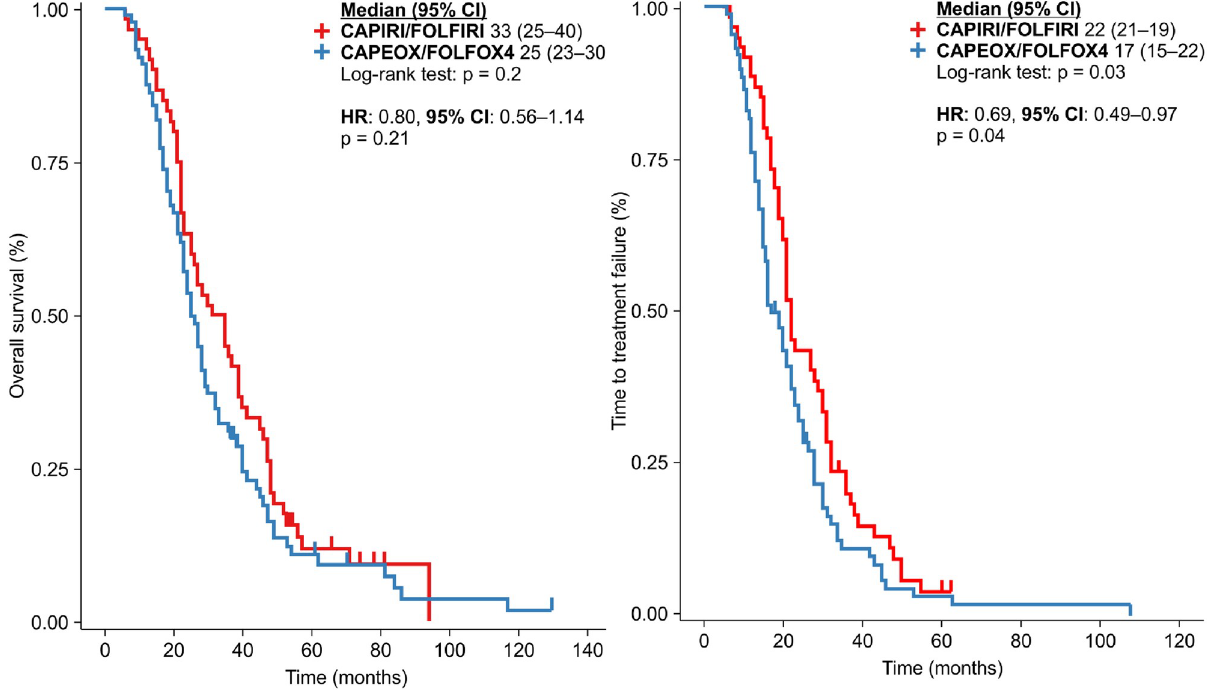
Fig 2. Overall survival and time to treatment failure for all patients in line with the backbone chemotherapy used: CAPIRI/FOLFIRI vs. CAPEOX/FOLFOX4.